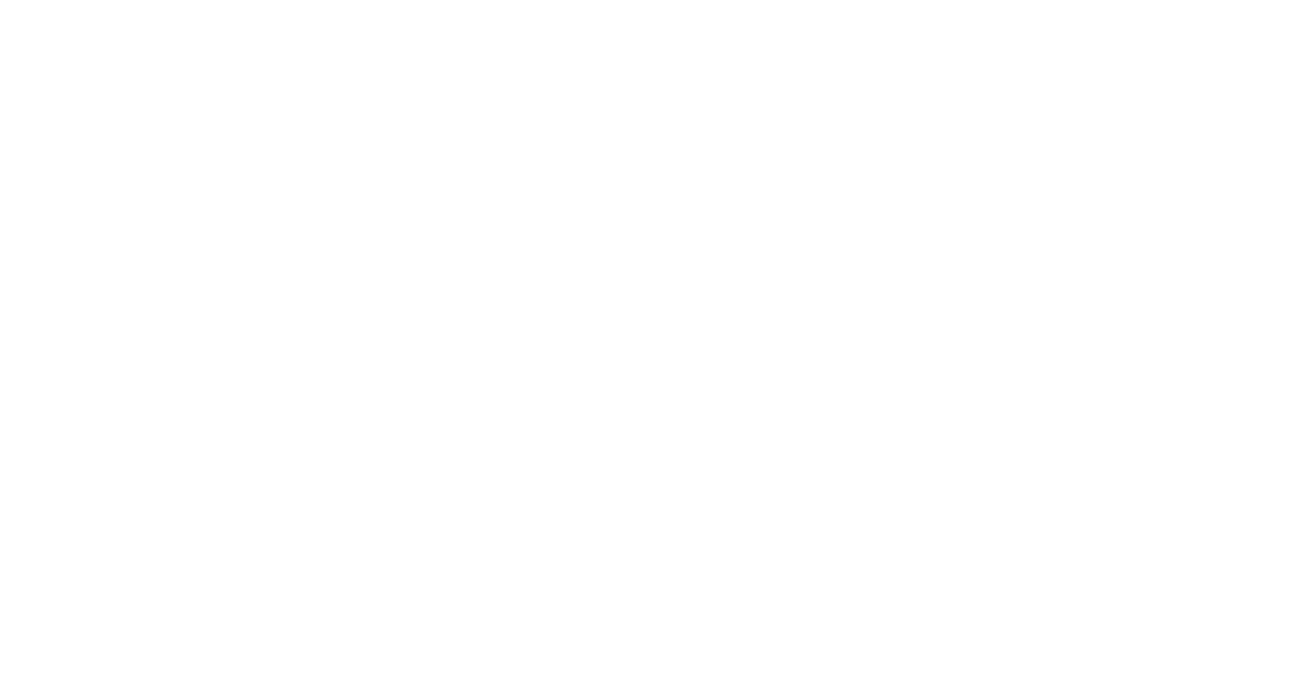
FIGURE 7 | (Left) 4 columns (8 panels): Fraction of CRAM protons that resonated in δ H ranges corresponding to peaks and bands defined in Table 2 . The sum of these sections accounted for ∼ 94% of the total CRAM envelope (see section CRAM). Far (Right) column (2 panels): Fraction of CRAM protons that resonated in the aliphatic and functionalized δ H ranges as defined in Table 1